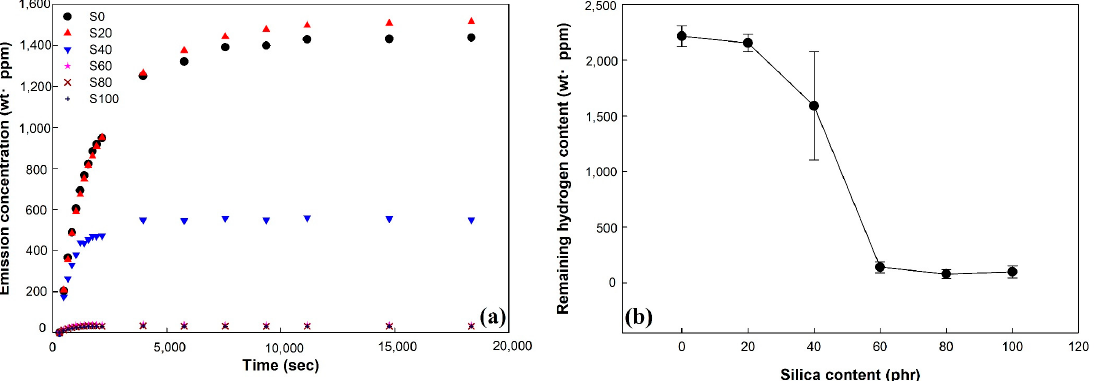
Figure 7. Emission concentration and remaining hydrogen content of EPDM/silica vulcanizates ex- posed to 96.3 MPa pressure hydrogen gas: ( a ) emission concentration and ( b ) remaining hydrogen content.